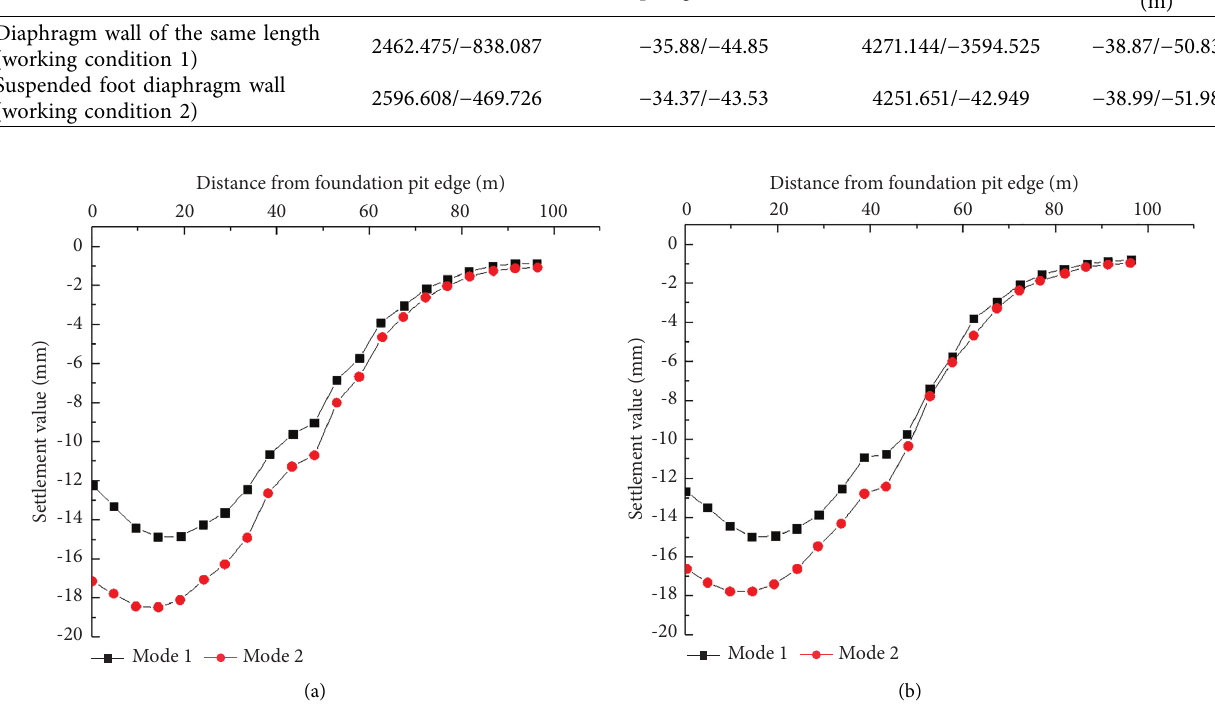
Figure 20: The curve of surface subsidence. (a) West wall. (b) East wall. Table 12: Summary of corresponding positions of maximum ground settlement during the 10th excavation step under two working conditions.